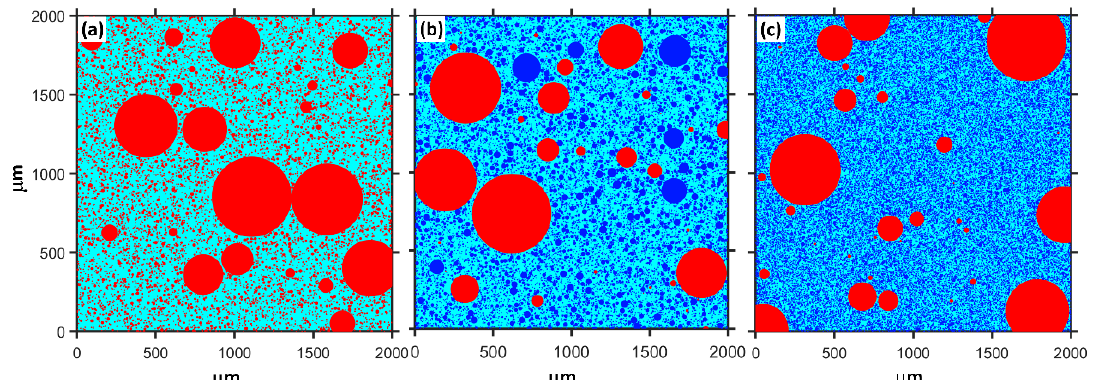
Figure 5. Schematic diagram of the random distribution of MgO and mineral admixtures in a box with a length of 2000 microns, M/P = 6, W/B = 0.16. Red: MgO; Blue: mineral admixture. ( a ) only MgO ( b ) with 40% ordinary powder and ( c ) with 40% ultrafine powder.